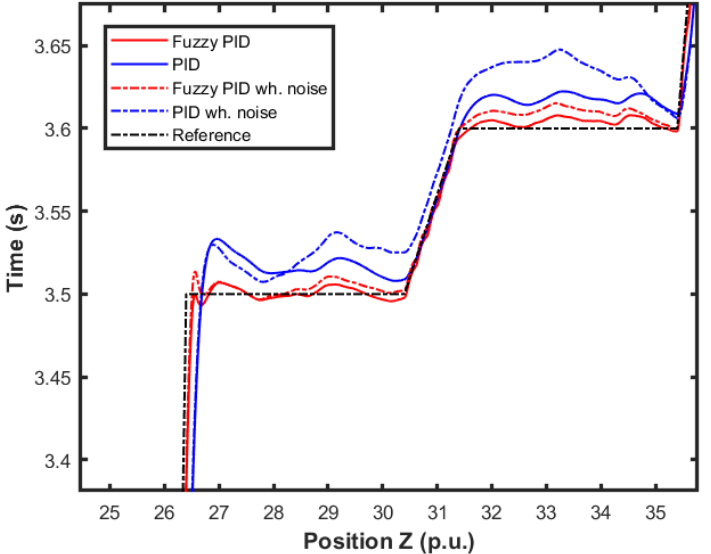
Figure 14. Detail of comparison of the proposed method and PID controller for altitude